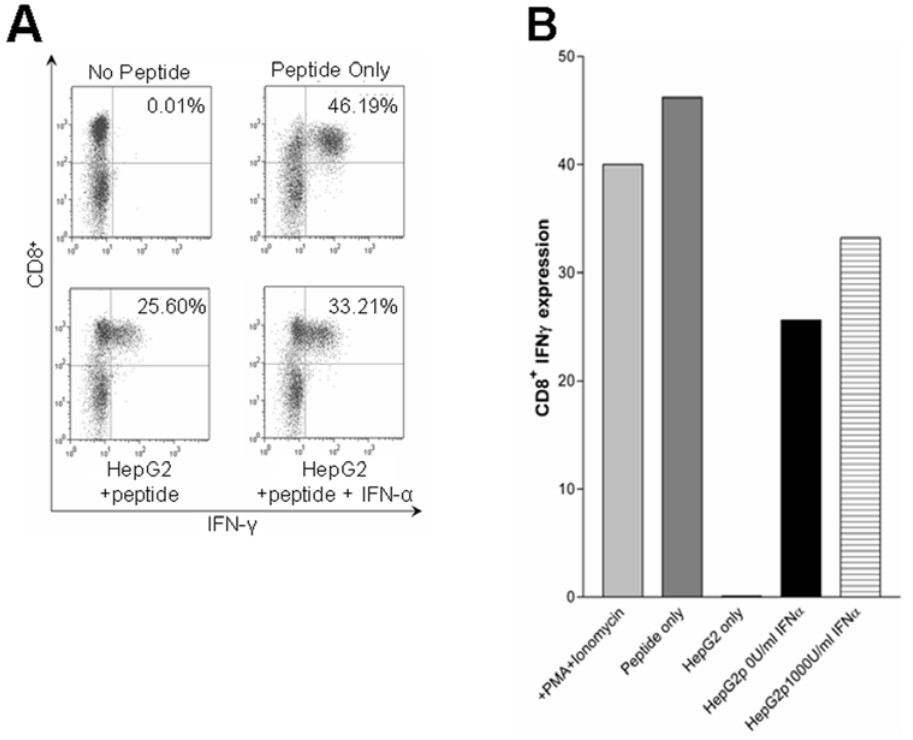
Figure 3. IFN- a stimulated hepatocytes are still able to act as APCs to CTL. HepG2 cells were stimulated for 16 hours with 1000 U/ml IFN- a , or left untreated. The cells were then pulsed with the specific cognate peptide and washed, prior to co-incubation with the CTL line 2. As controls non- peptide-pulsed cells were used, or all PBMC were peptide pulsed or stimulated with PMA/ionomycin. A ) The raw FACS data showing the CD8 + expression on the y axis’s and IFN- c on the x axis’s. B ) The percentage secretion data from such experiment. HepG2p represents peptide pulsed cells with or without IFN- a stimulation as indicated. This data is representative of 4 such experiments.